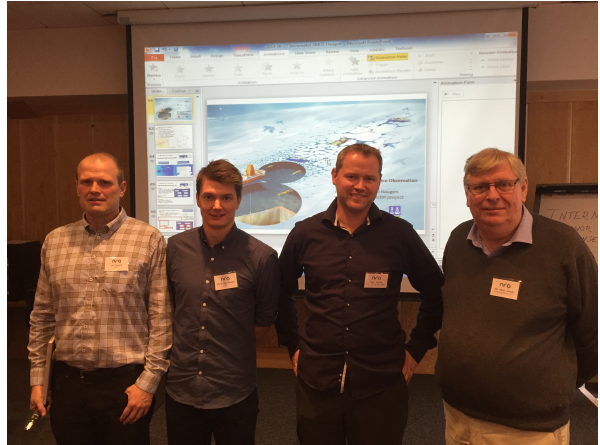
Figure 4: Participation Servomøtet 2014 at Kongsberg, Norway. From left: Lars Imsland, Øivind K. Kjerstad, Roger Skjetne, and Nils A.